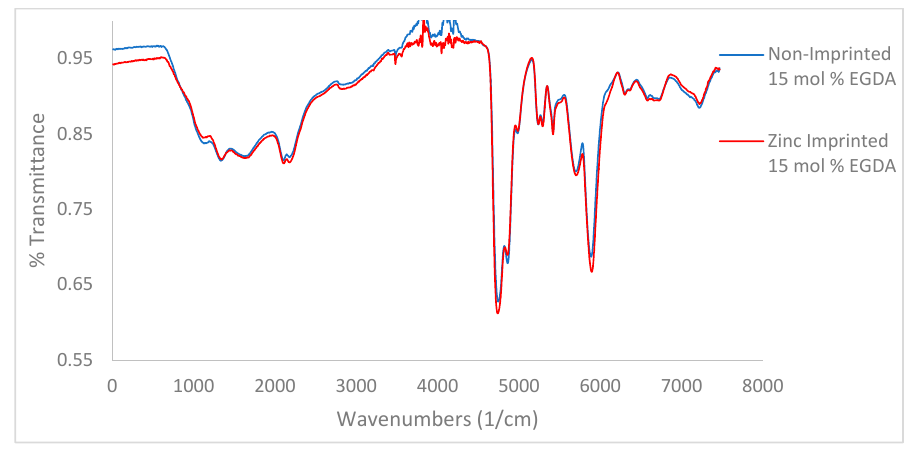
Figure 3 . IR spectra for variable crosslinker (EGDA) study. Top to bottom 5, 10, and 15 mol %. No tBA present.